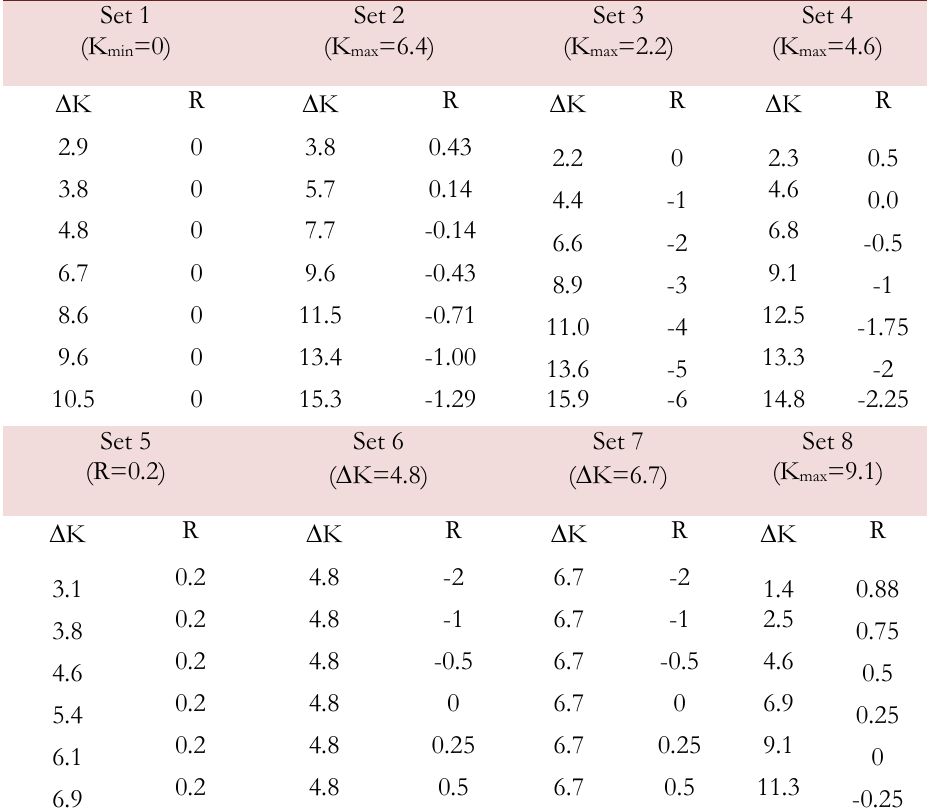
Table 1: Loading parameters for 6016-T4 aluminium alloy (  K, K max , K min  =MPa.m 1/2